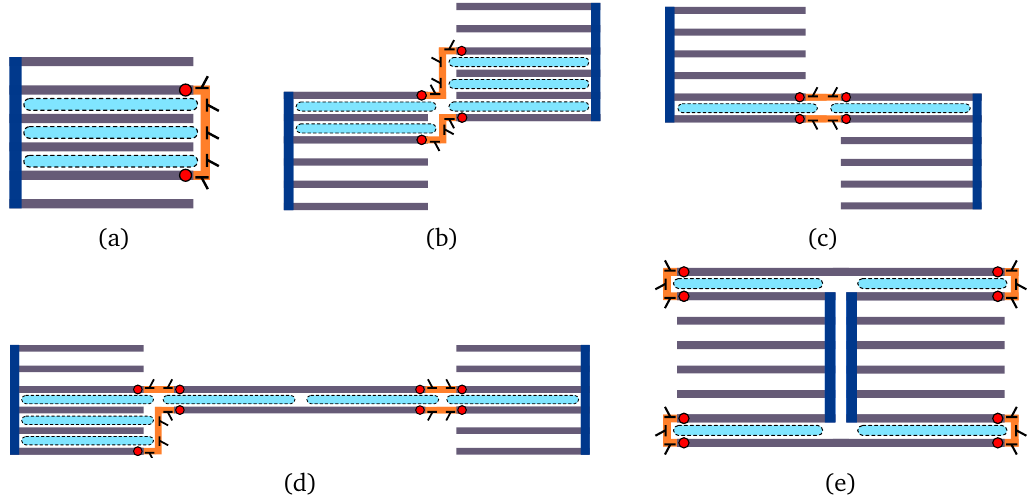
Figure 4: Various fermionic parity measurement configurations for the one-sided = 3 vertical cutter gates hexon architecture. (a) A 2-MZM measurement with n c = 3 units of area enclosed by the interference loop, and n = 2 tun- opened, n a t neling junctions to MZMs. (b) A 4-MZM measurement in the upward direction, = 3, n = 5 , and n = 4 . (c) A 4-MZM measurement in the downward with n c a t = 0 , n = 2 , and n = 4 . (d) A 4-MZM measurement in the direction, with n c a t = 2 , n = 6 , and n = 8 . (e) A 4-MZM measurement rightward direction, with n c a t = 4 , n = 4 , and n = 8 . in the leftward direction, with n c a t will be easier for smaller dots. We use the number of vertical cutter gates involved in a measurement as simple placeholder for the length of the semiconducting